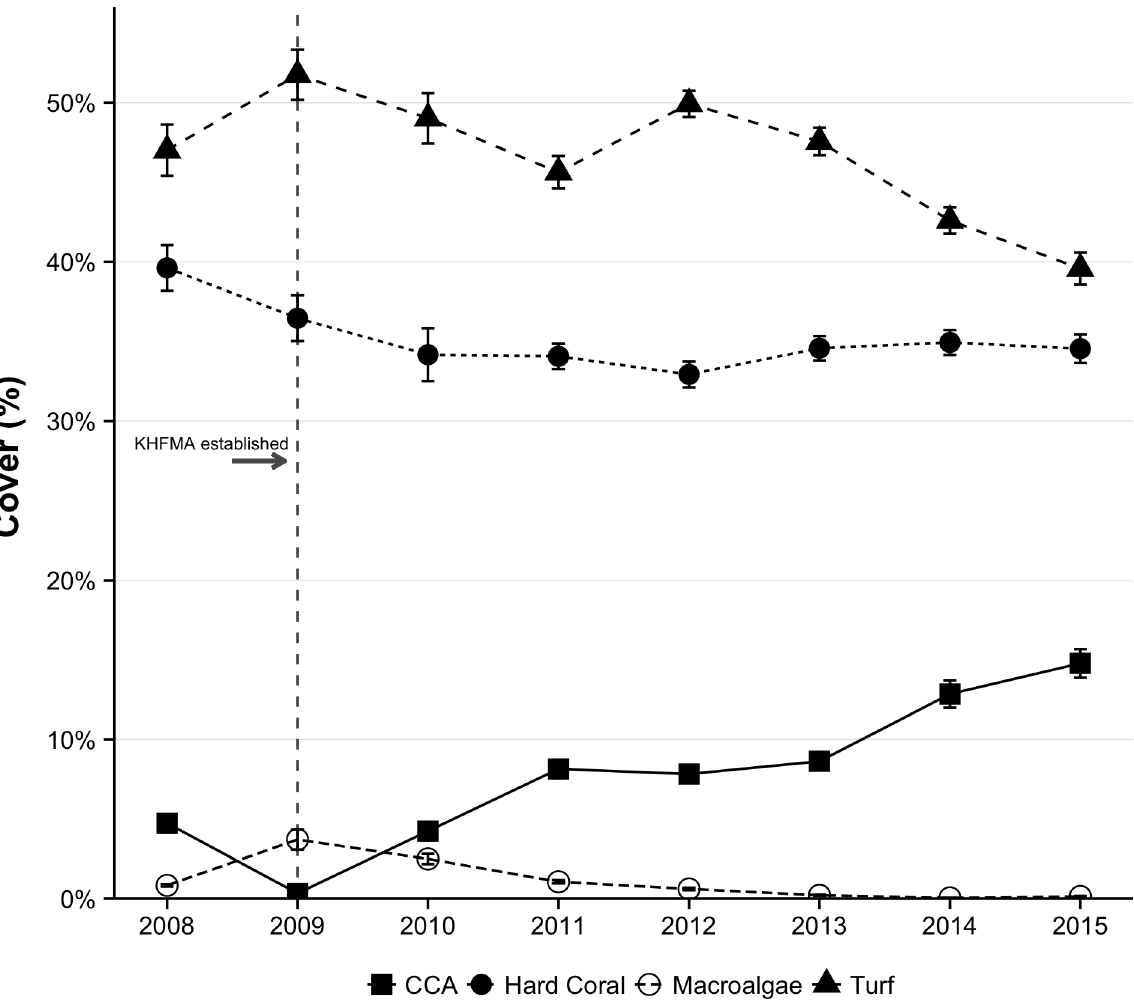
Fig 6. Trends in benthic cover at KHFMA. Data shown are annual mean and standard